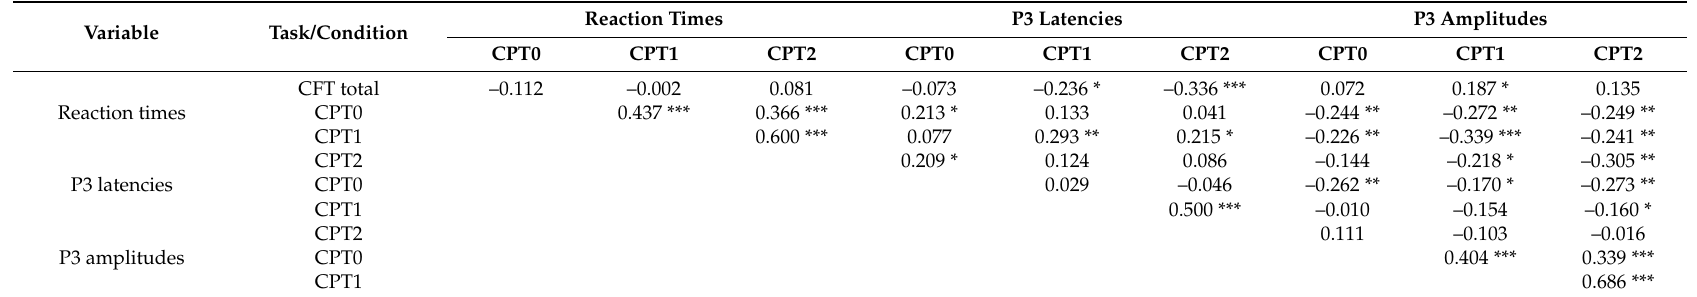
Table 2. Pearson correlations between reaction times, P3 latencies, and P3 amplitudes in the three conditions of the continuous performance test (CPT0 to CPT2), as well as scores on the CFT-20 R in 110